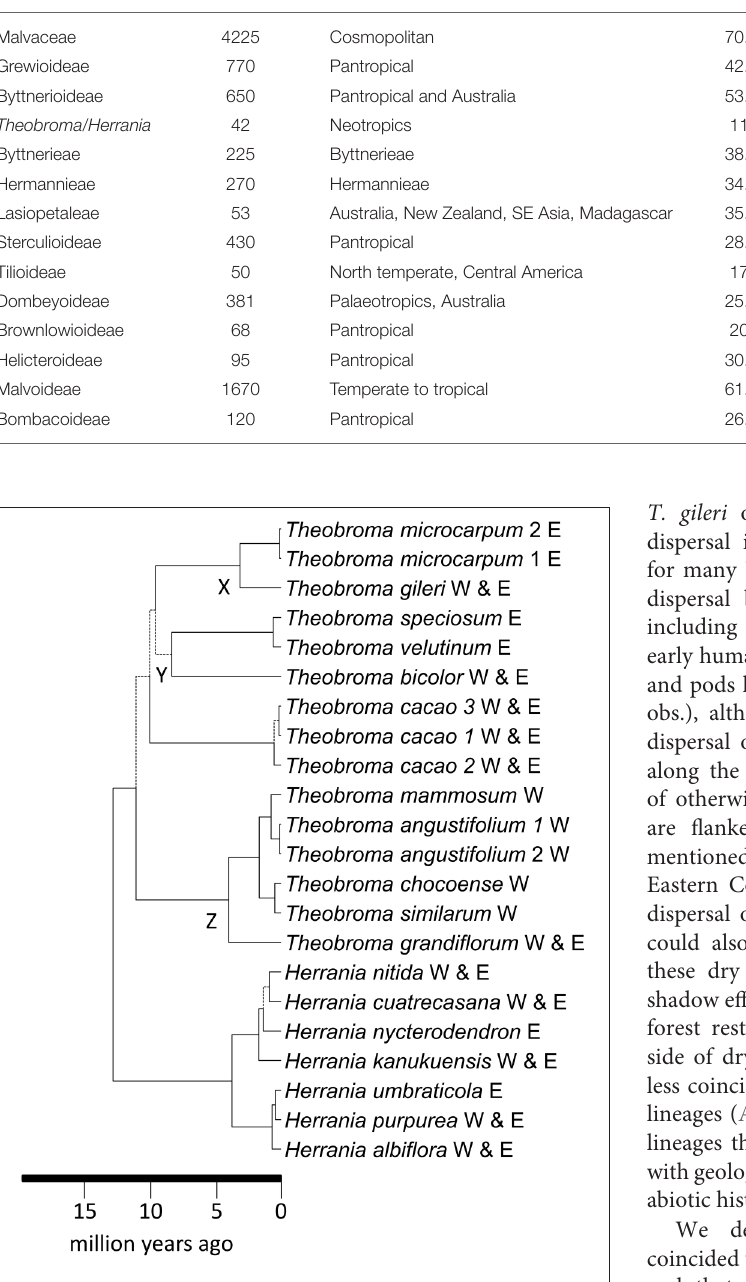
FIGURE 3 | Maximum clade credibility tree resulting from the BEAST analysis of the WRKY data. Broken lines represent branches with < 0.95 pp -values. Trans-Andean splits in the phylogeny indicated at nodes X and Y. W, west of the Andes; E, east of the Andes.